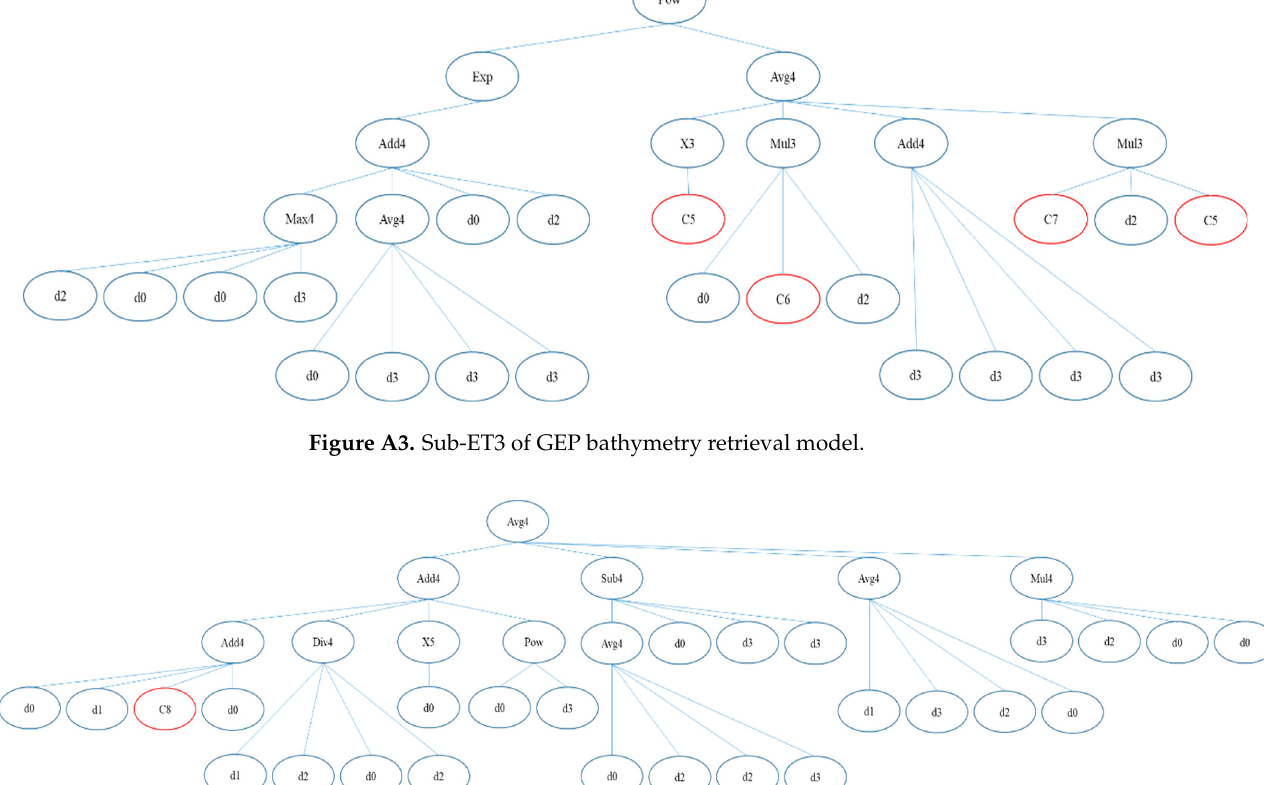
Figure A4. Sub-ET4 of GEP bathymetry retrieval model.